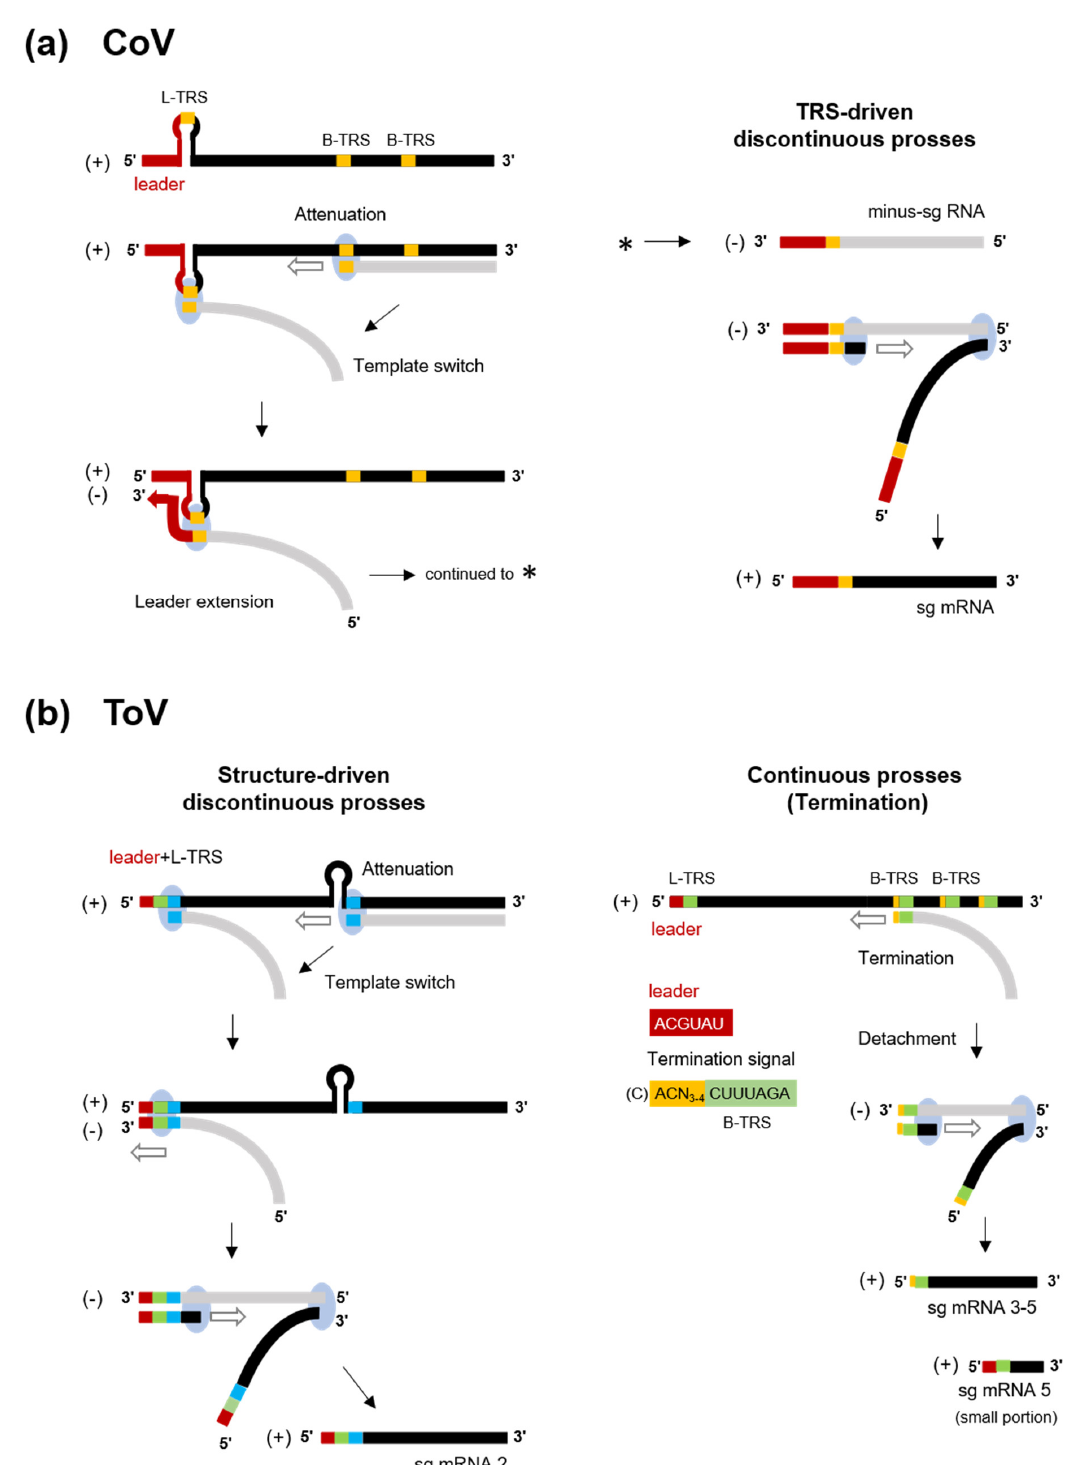
Figure 4. Discontinuous and continuous transcription of CoV and ToV. ( a ) Model of TRS-driven discontinuous transcription of CoV. (-) RNA synthesis (light grey) initiates at the 3’-end of the genome and is terminated or attenuated when the replication and transcription complex (light blue circle) encounters B-TRS (in orange). The discontinuous step is driven by base-pairing between the anti-B-TRS and L-TRS within the hairpin, resulting in template switch from nascent (-) RNA to the leader. Next, (-) RNA synthesis re-initiates and a leader sequence (red) is added. This complete (-) sg RNA in turn serves as a template for (+) sg mRNAs. ( b ) Model of structure-driven discontinuous (left) and continuous (right) transcription of ToV. In sg mRNA2, nascent (-) RNA synthesis is terminated by the hairpin (HP) structure and base pairing between